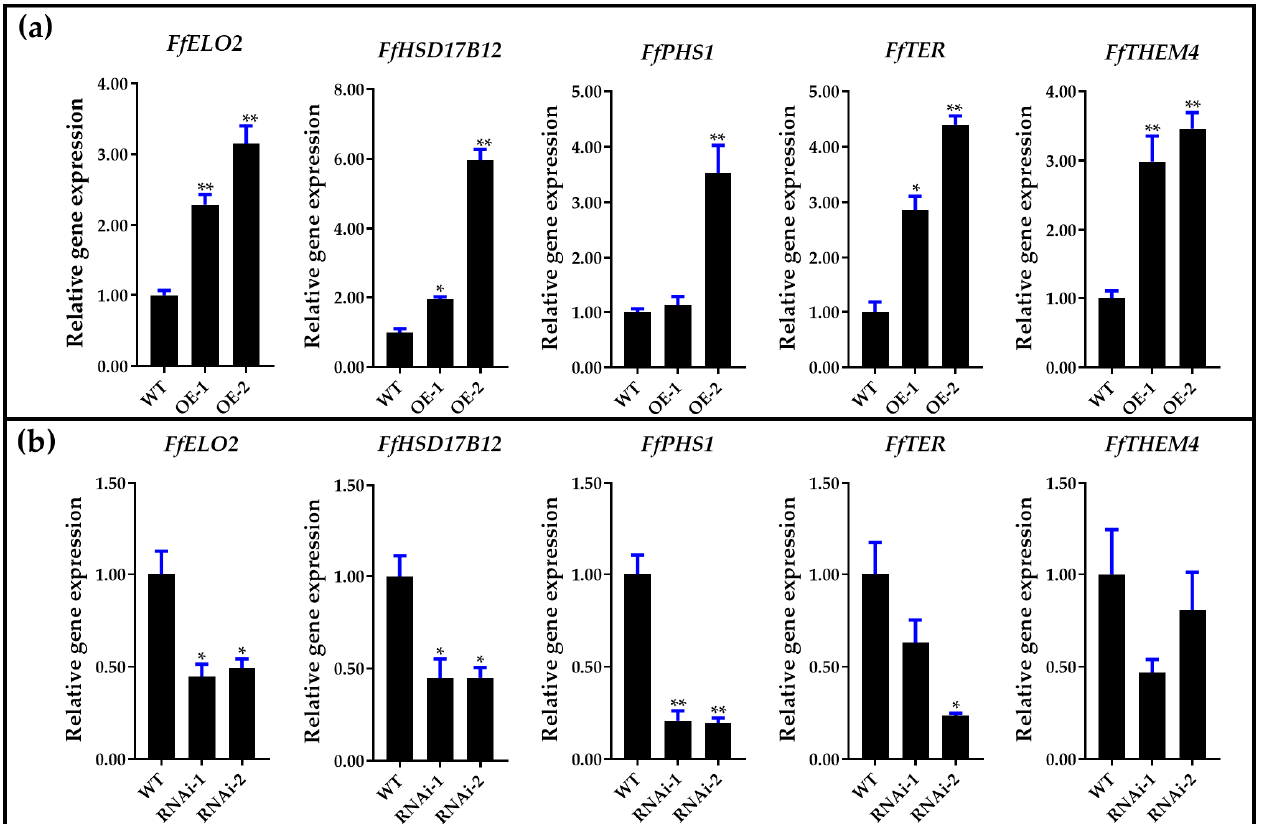
Figure 13. Expression of long-chain fatty acid synthesis of fatty acid elongation pathway (PATH: map00062, Module: M00415) genes in DPI and water treatment samples. Significance levels were calculated by t -test ( n = 4), ** p < 0.01.